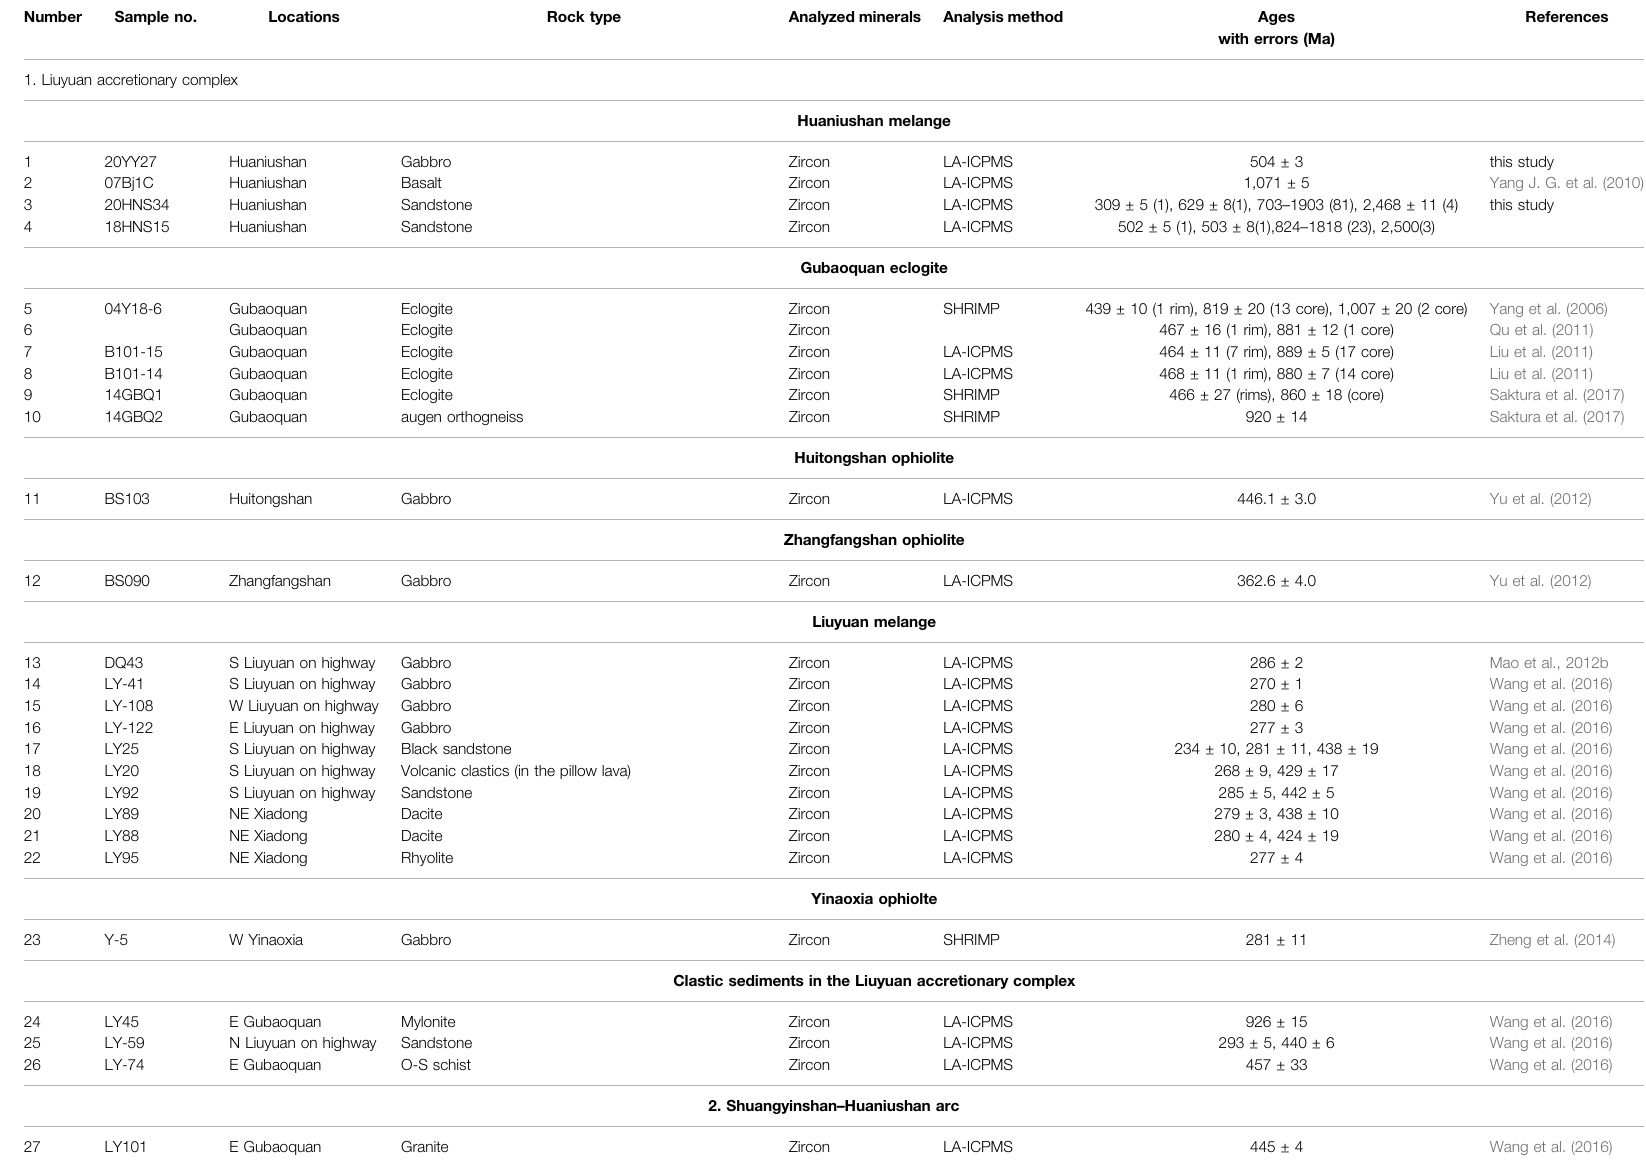
TABLE 5 | Regional age data for the Liuyuan accretionary complex. Number Sample